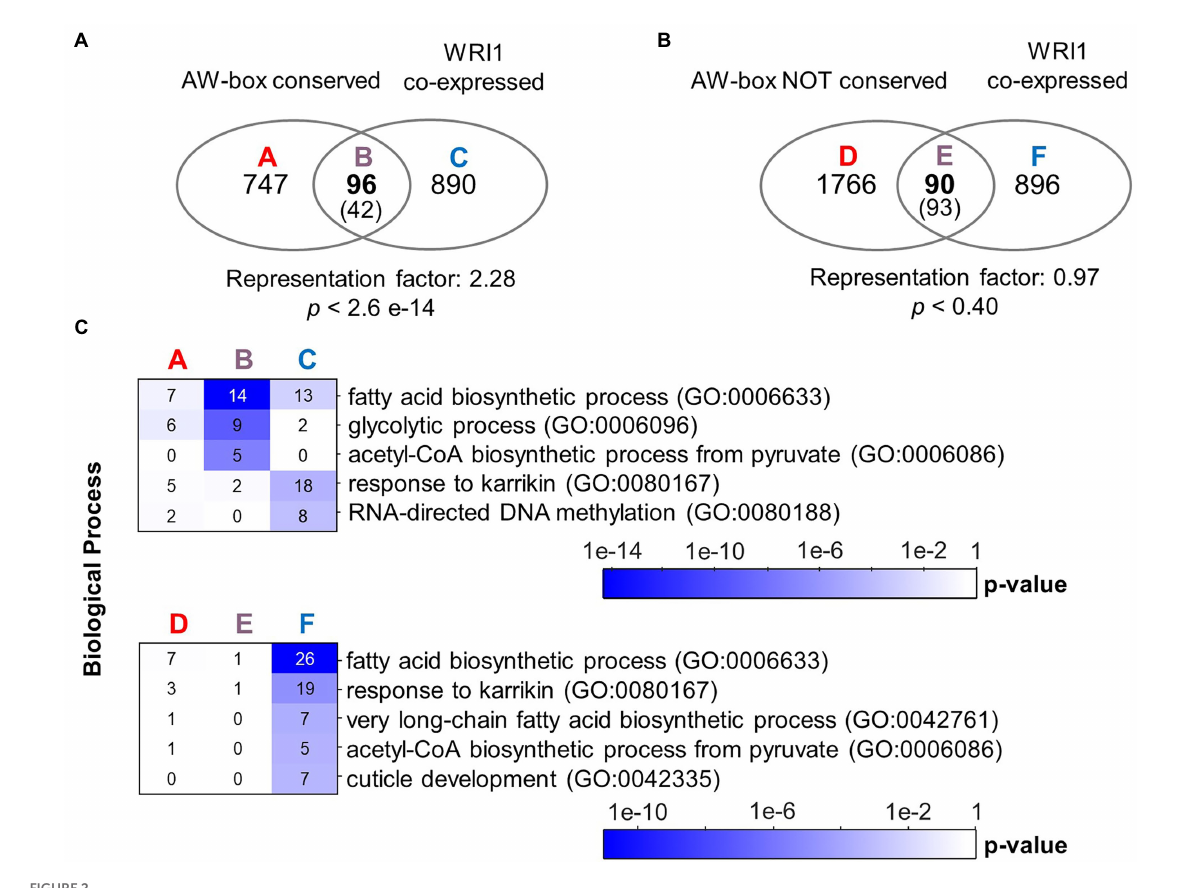
FIGURE 2 Conservation of the AW-box across orthologous upstream regions identifies likely WRI1 gene targets. (A) Overlap of A. thaliana genes with AW-box conserved in five or more other species (Species conservation ratio ≥ 0.5). In the intersect, expectation values are shown in parentheses. Statistical significance is indicated by hypergeometric p value. (B) Venn diagram like panel A, but considering only genes for which the AW-box is present upstream A. thaliana, but no AW site is conserved (Species conservation ratio 0). (C) Overrepresentation of GO biological processes among sets A to E is shown in panels A and B. Numbers on the heat maps are gene counts. A seed development transcriptomic dataset of Schneider et al. (2016) was mined (see methods). Co-expressed genes are defined by a cutoff for the Pearson correlation coefficient ( R -value) of 0.943. GO term analysis was performed using the DAVID version 6.8 online resource (https://david.ncifcrf.gov/; Huang da et al., 2009). Abbreviation: OUR, orthologous upstream